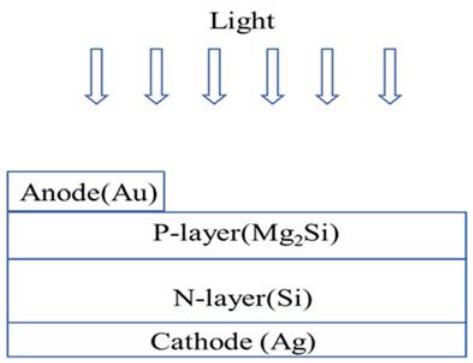
Figure 1. The cross section of the p-Mg 2 Si/n-Si heterojunction PD model.